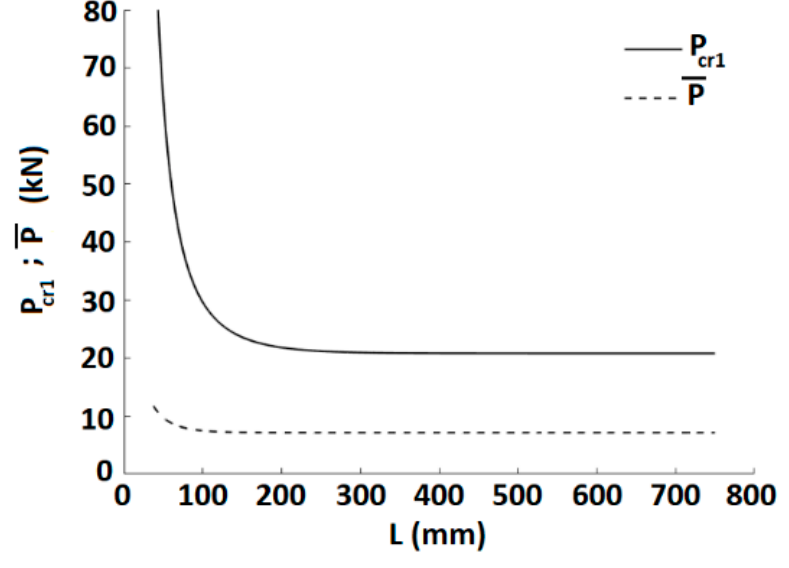
Figure 4. Dependence of cracking load on the rebar length.